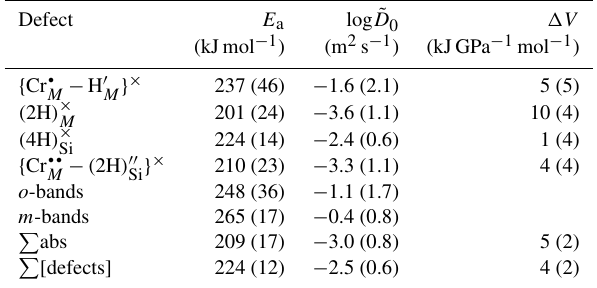
Table 4. Fitting parameters associated with Eq. (4), for individually resolved defects, for (cid:80) abs, whereby ˜ D s associated with the sum of absorbance of all defects was fitted together (not including any wavenumber specificity), and (cid:80) [defects], where all extracted ˜ D s were fitted together. Uncertainties are 1 σ . The reference pressure